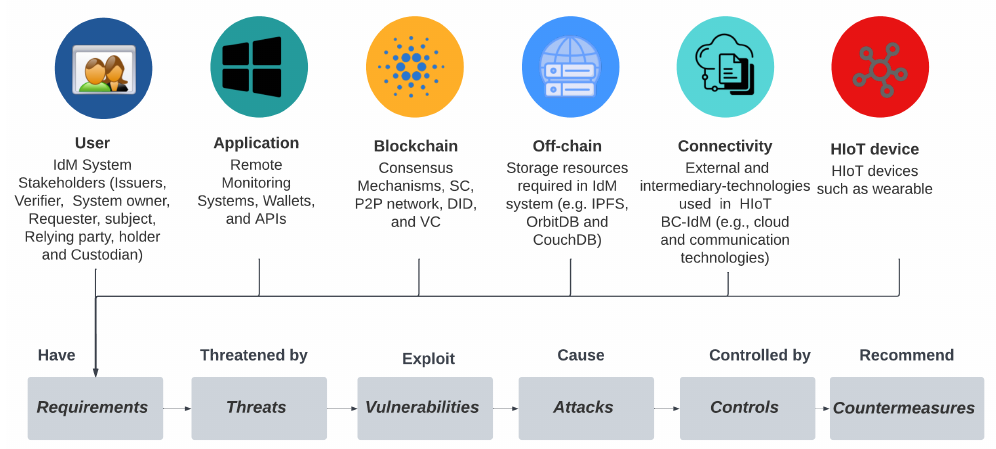
Figure 5. HIoT BC-IdM system security